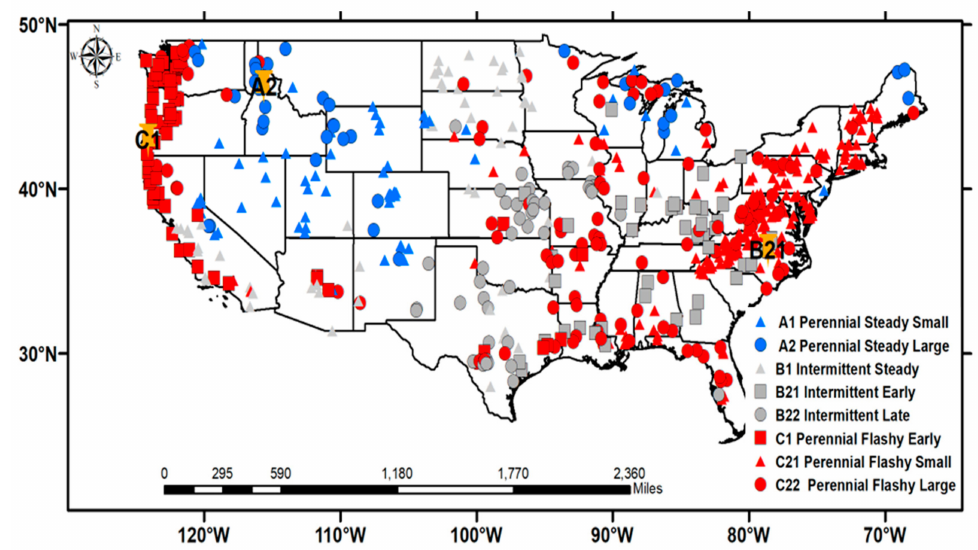
Figure 2. Spatial distribution of eight watershed classes across the US. The pushpin symbol indicates the study sites selected for observed and simulated streamflow comparison.